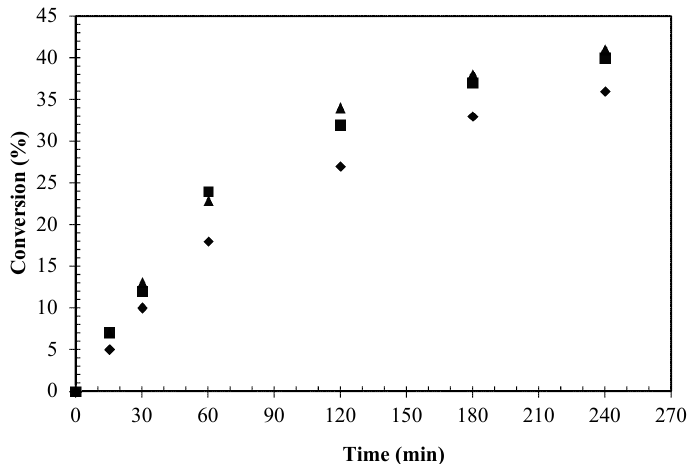
Figure 5. Effect of speed of agitation. Temperature: 150 °C, Catalyst loading: 0.03 g/cm 3 , Glycerol: BA = 1:3, reaction duration 4 h. ( ) 600 rpm; ( ) 800 rpm; ( ) 1000 rpm.